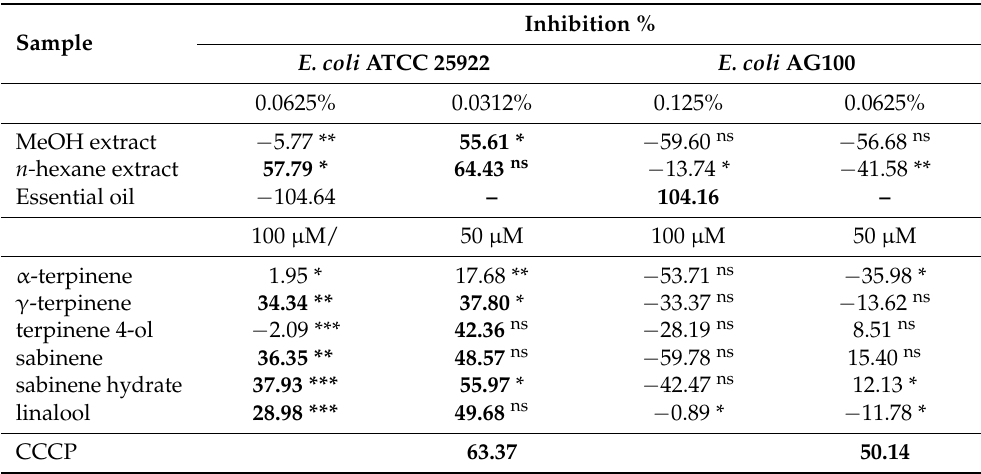
Table 6. Antibiofilm effect of extracts, essential oil of O. majorana and its monoterpene components on sensitive and resistant E. coli strains 1 .